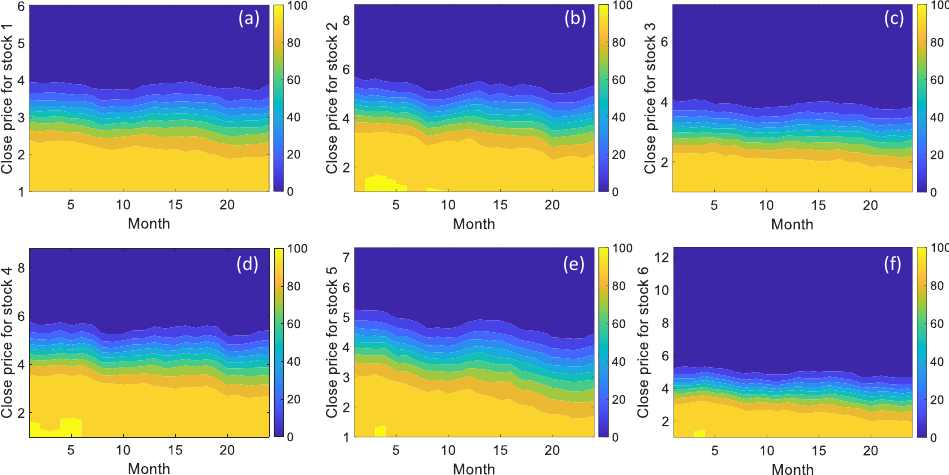
Figure 9. Contour plots of exceedance probability of stock price through time; ( a ) Stock 1; ( b ) Stock 2; ( c ) Stock 3; ( d ) Stock 4; ( e ) Stock 5; ( f ) Stock